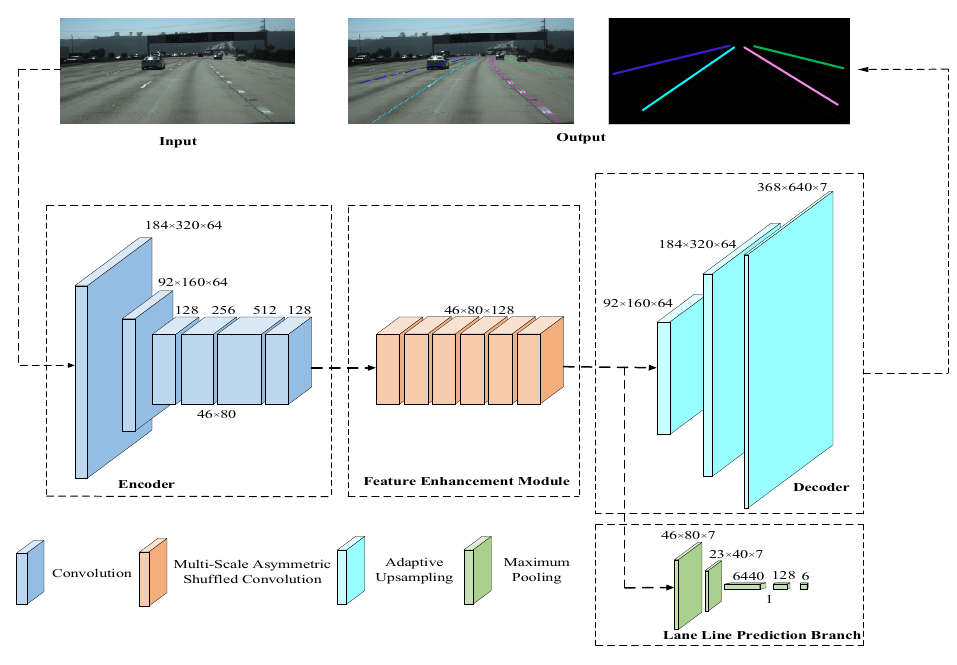
Figure 8. Lane detection model.